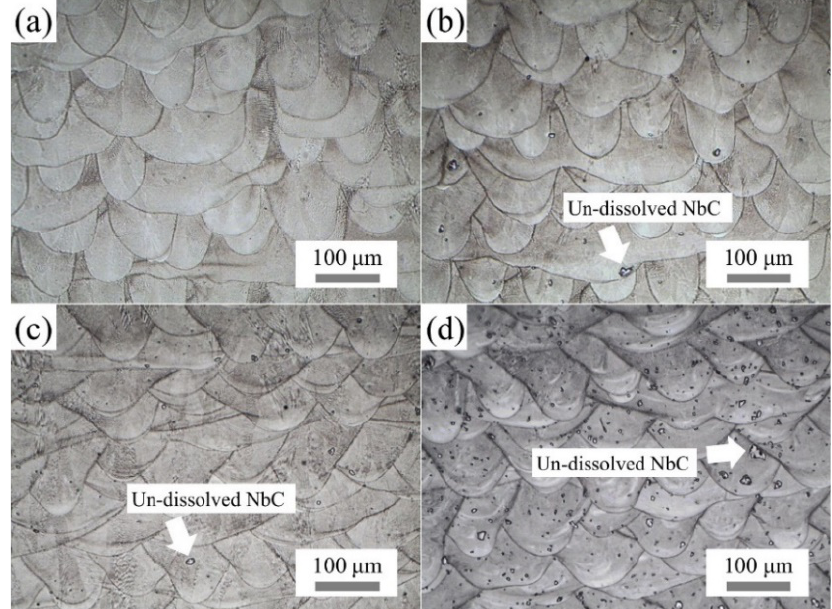
Figure 3. Cross-sectional views of melt pool morphology ( a ) without NbC, ( b ) with 0.5% NbC, ( c ) with 1.0% NbC, and ( d ) with 5.0% NbC in weight.